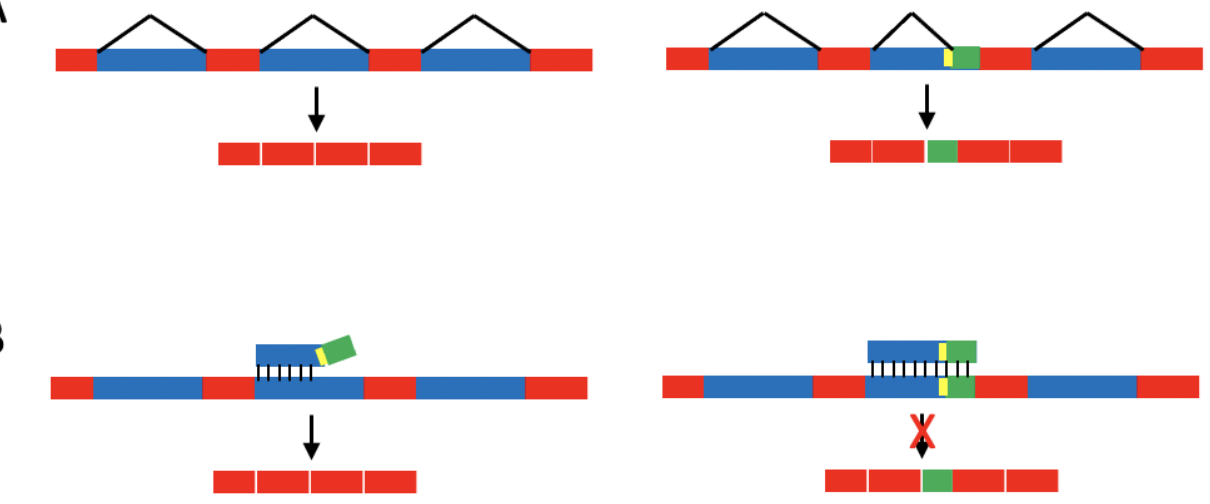
Figure 3. Allele specific oligonucleotides (ASOs) can form either DNA:DNA or DNA:RNA duplexes. In cases where one allele has an intronic or exonic base change (yellow) that generates an alternate splice site ( A ), the ASO can bind by base pairing to block splicing at that site ( B ). Mismatched bases will not allow the ASO to bind to the wild type sequence. Alternately, the ASO could bind to intronic sequences containing cis-acting regulatory sites in wild type sequences to alter the relative abundances of naturally-occurring alternative splicing variants.